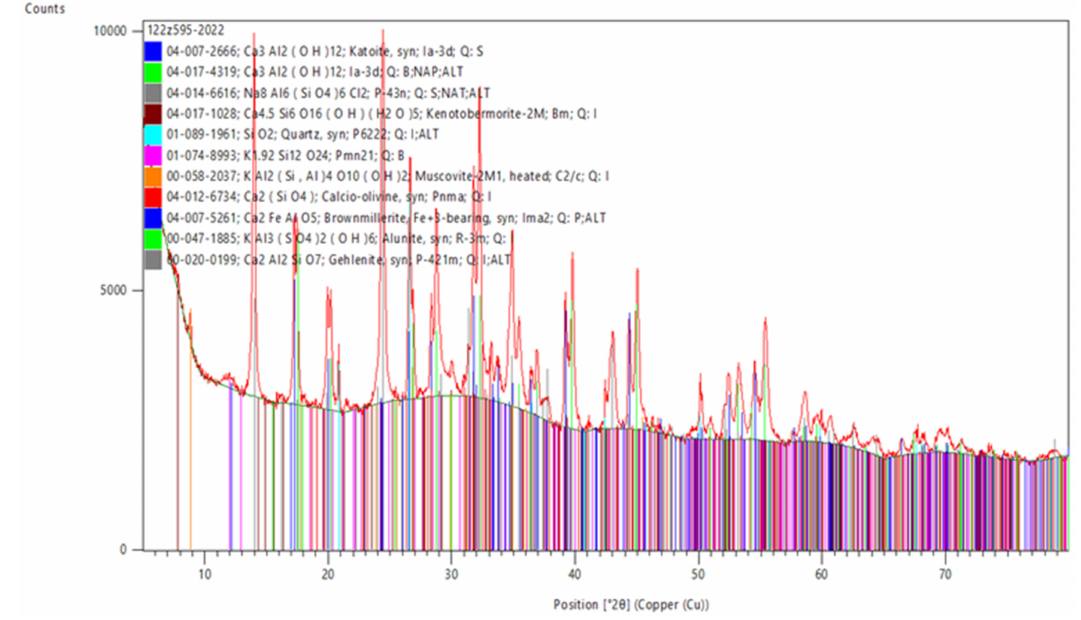
Figure 21. XRD pattern of M.6.0.z specimen.